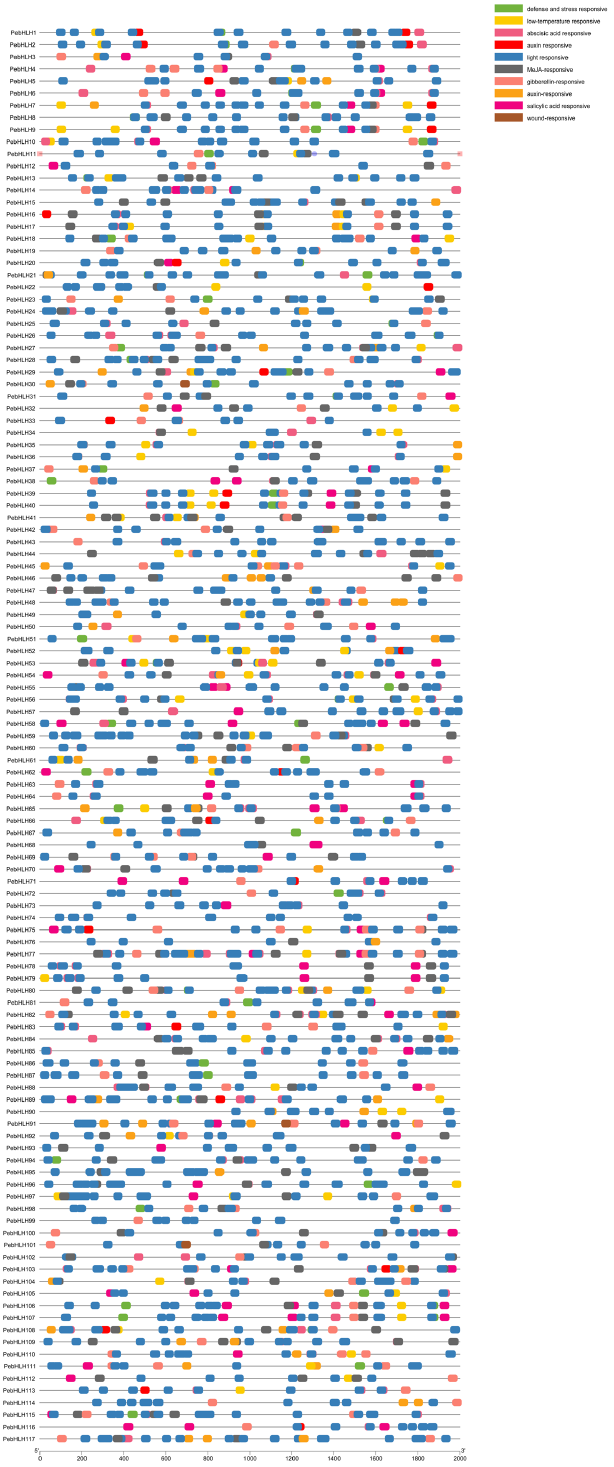
Figure 4. The cis-acting element analysis of 2000 bp promoter upstream of PebHLH genes. Functional descriptions of cis-acting elements were labeled by different